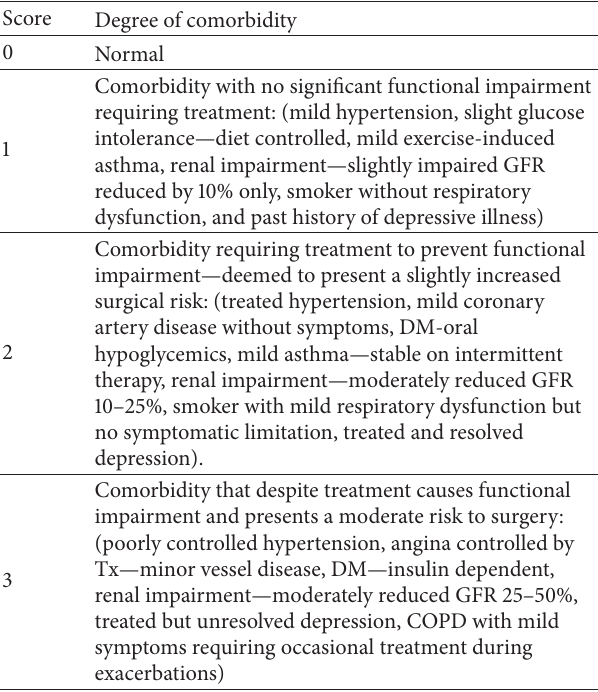
Table 1: Pretransplant risk assessment score for intestinal and multivisceral transplantation in adults. The score was assigned to the severity of each comorbidity resulting in a cumulative comorbidity score.